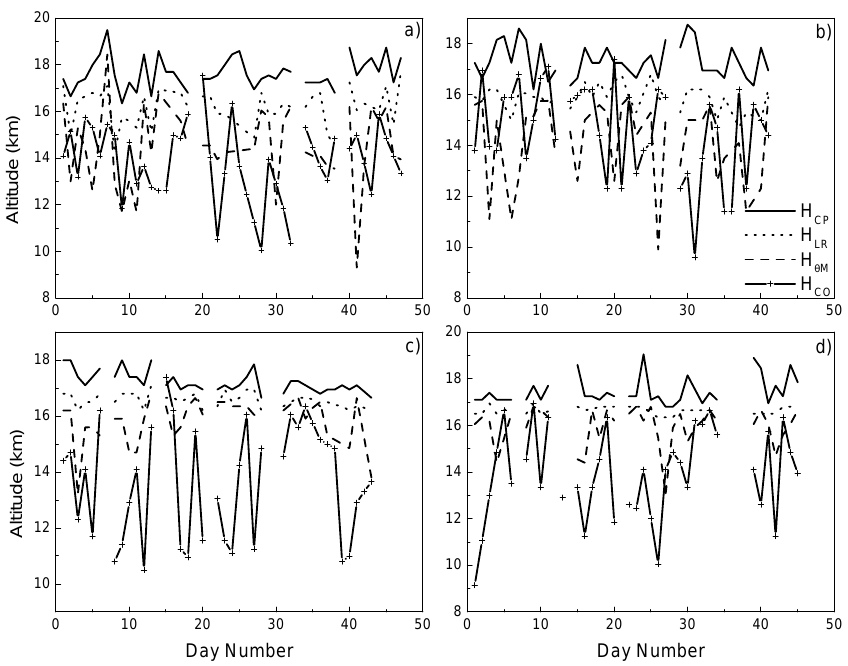
Fig. 3. Day-to-day variations of tropopause altitudes H CP , H LR , H θM , and H CO for (a) winter 1999, (b) winter 2000, (c) summer 2001 and (d) winter 2002.